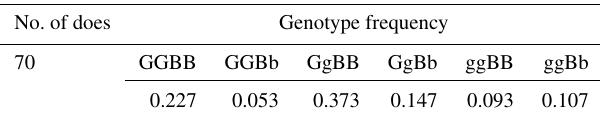
Table 4. Combined genotypic frequencies of GDF9 and BMP15 genes. No. of does